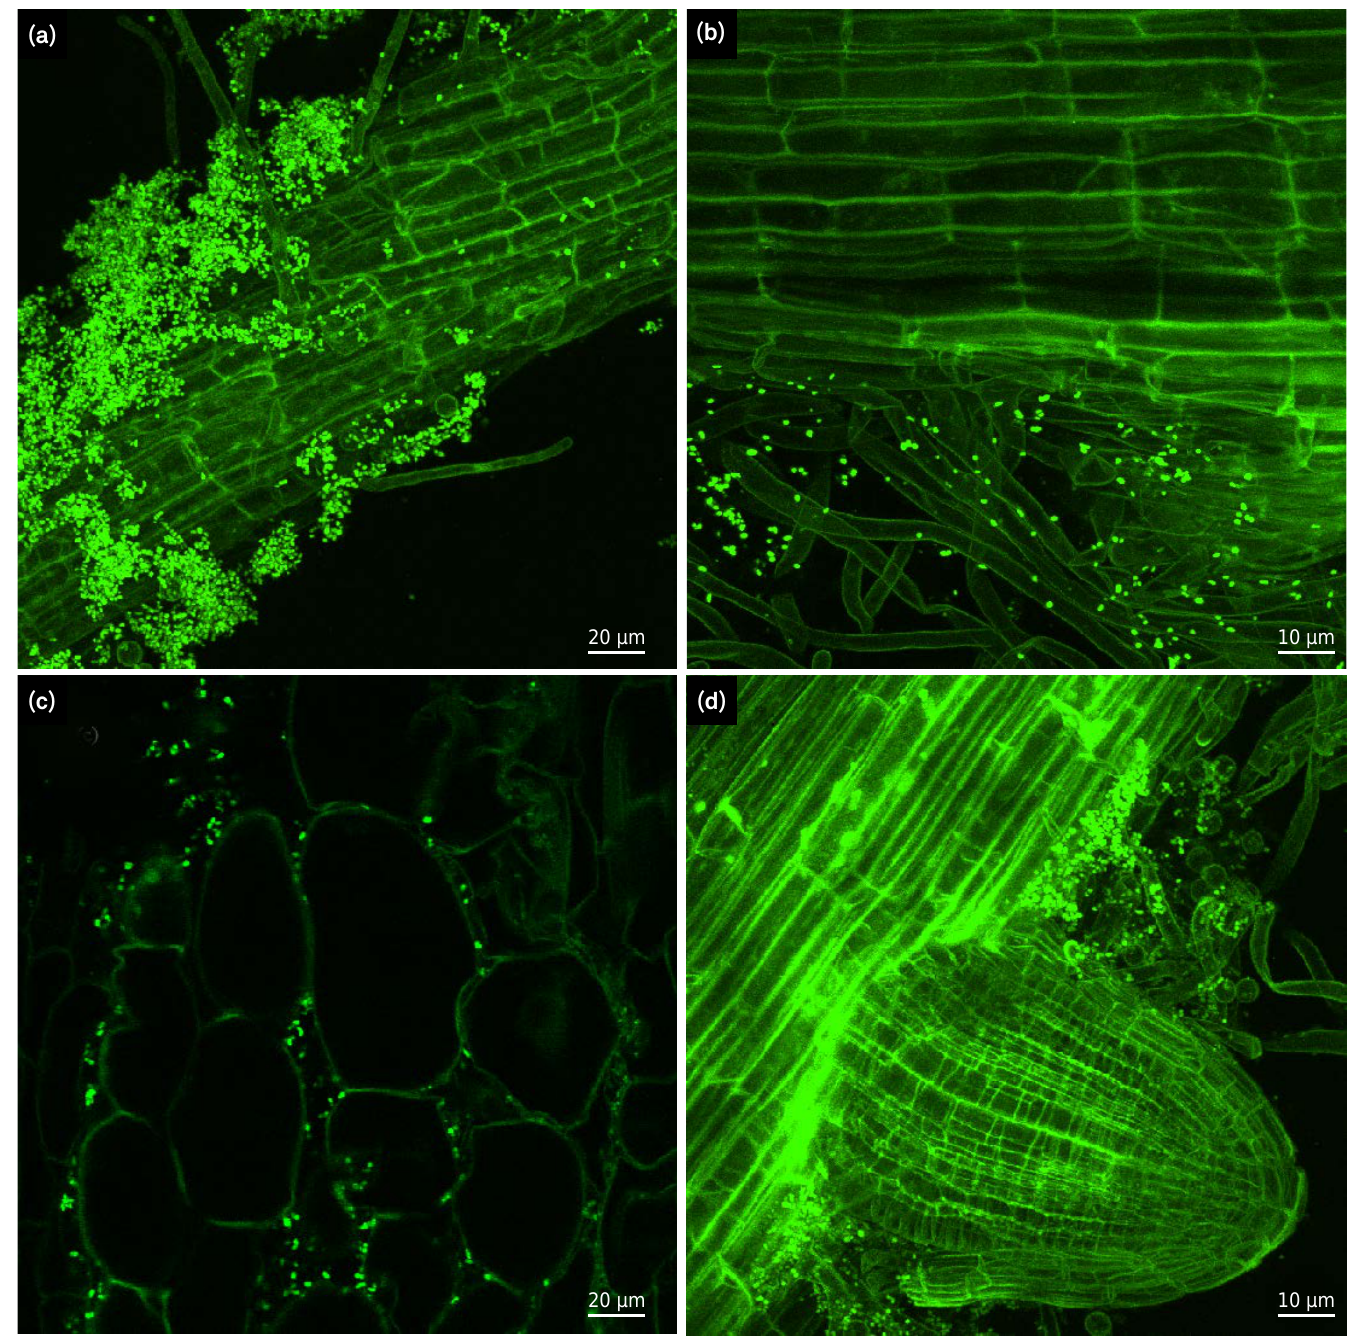
Figure 1. Confocal laser scanning microscopy micrographs of longitudinal cuts in rice seedling fragments. (a) Rhizobia Burkholderia sp. Vp16gfp colonizing the rhizoplane in the rice seedling root hair zone after 10 days of growth. (b) Rhizobia Mesorhizobium sp. Lc348gfp colonizing the rhizoplane in the rice seedling root hair zone after 20 days of growth. (c) A. brasilense Ab-V5gfp in the intercellular colonization of the epidermis in the branching zone of the rice seedling root after 20 days of growth. (d) Colonization by the rhizobia Burkholderia sp. Vp16gfp in the rice seedling lateral root emission region after 20 days of